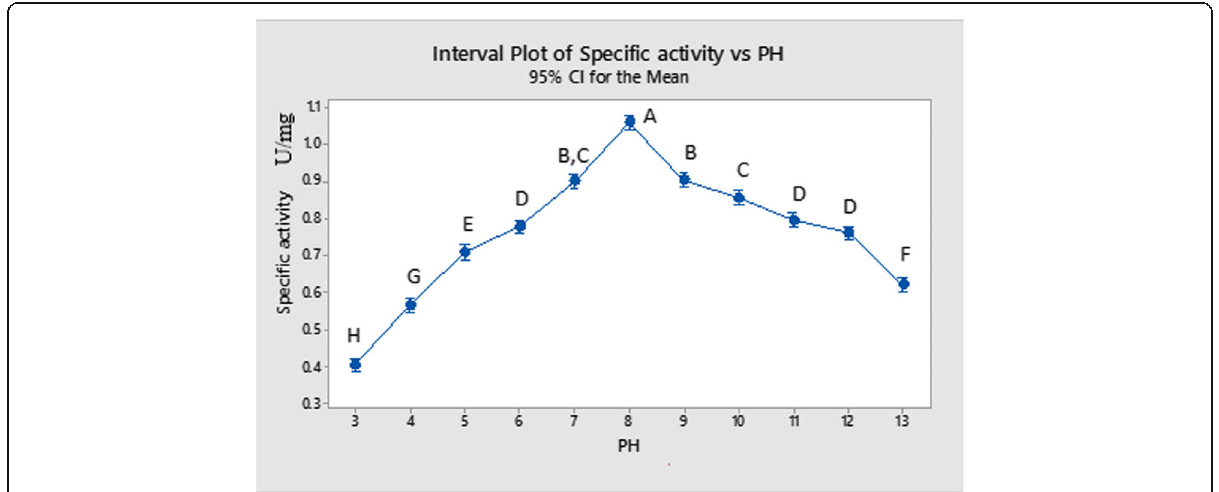
Fig. 5 Effect of pH on activity of purified fat body lipase from larvae of G. mellonella by using different pH range. Different letters indicate significant differences ( p < 0.05), (no. of replicates = 3)